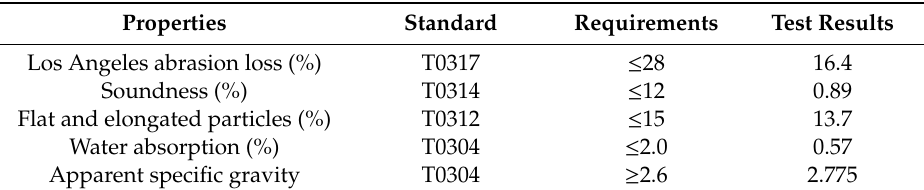
Table 1. Basic properties of aggregates.